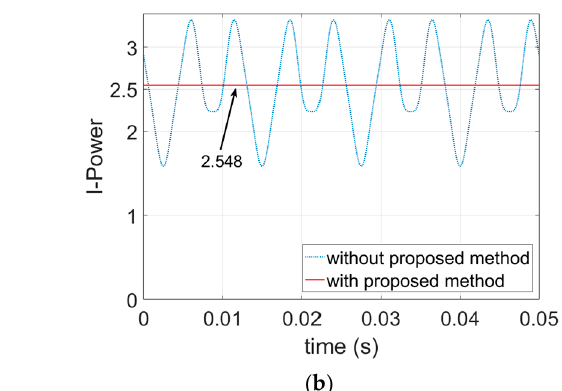
Figure 5. I-power graphs for the adjacent double-phase OCFT condition currents: ( a ) Fundamental; ( b ) fundamental plus third harmonic.